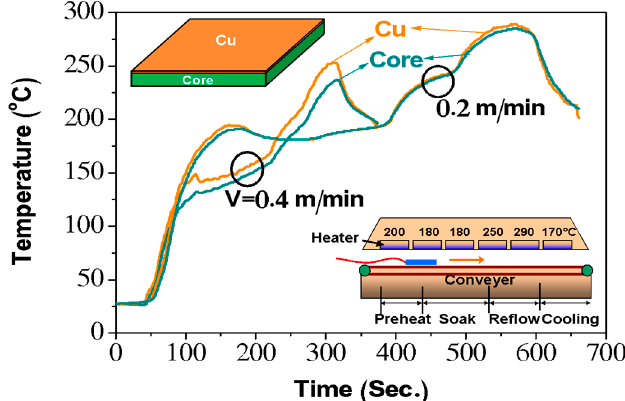
Figure 4. Temperature profiles for a Cu/core bi-material specimen with a size of 40 × 40 × 0.4 mm (Cu 0.03 mm/core 0.37 mm in the thickness) in an IR reflow process with a conveyer velocity of 0.2 m/min and 0.4 m/min.